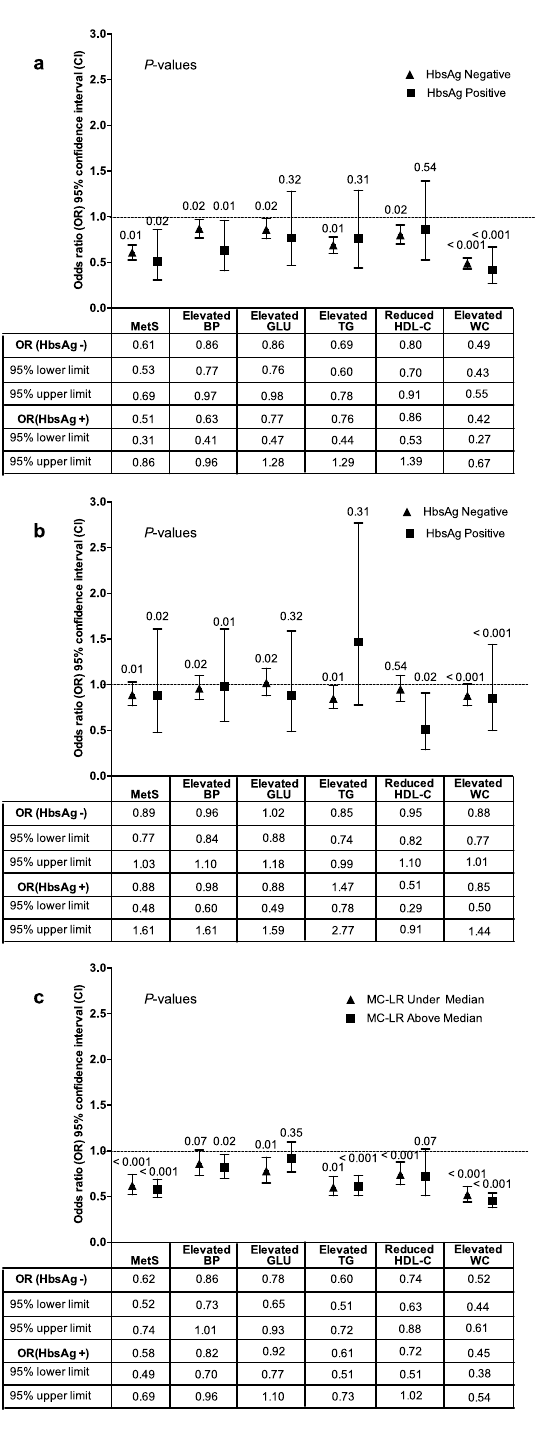
Figure 6. The modification effects of HBV infection on relationships of MetS and its constituents with AFB1 exposure and MC-LR exposure; and the modification effects of MC-LR exposure on relationships of MetS and its constituents with AFB1 exposure. ( a ) The modification effects of HBV infection on the association between MetS and Aflatoxin B1 exposure. ( b ) The modification effects of HBV infection on the association between MetS and MC-LR exposure. ( c ) The modification effects of MC-LR exposure on the association between the MetS and Aflatoxin B1 exposure. The higher AFB1 exposure significantly decreased the risk of MetS no matter whether the HBV infection was positive or negative. For people with the higher AFB1 exposure, the number of the constituents of MetS with decreased risk was higher in those without HBV infection than in those with HBV infection. For people either with or without HBV infection, those exposed to the higher or lower MC-LR levels showed no difference in the risk of MetS and all its